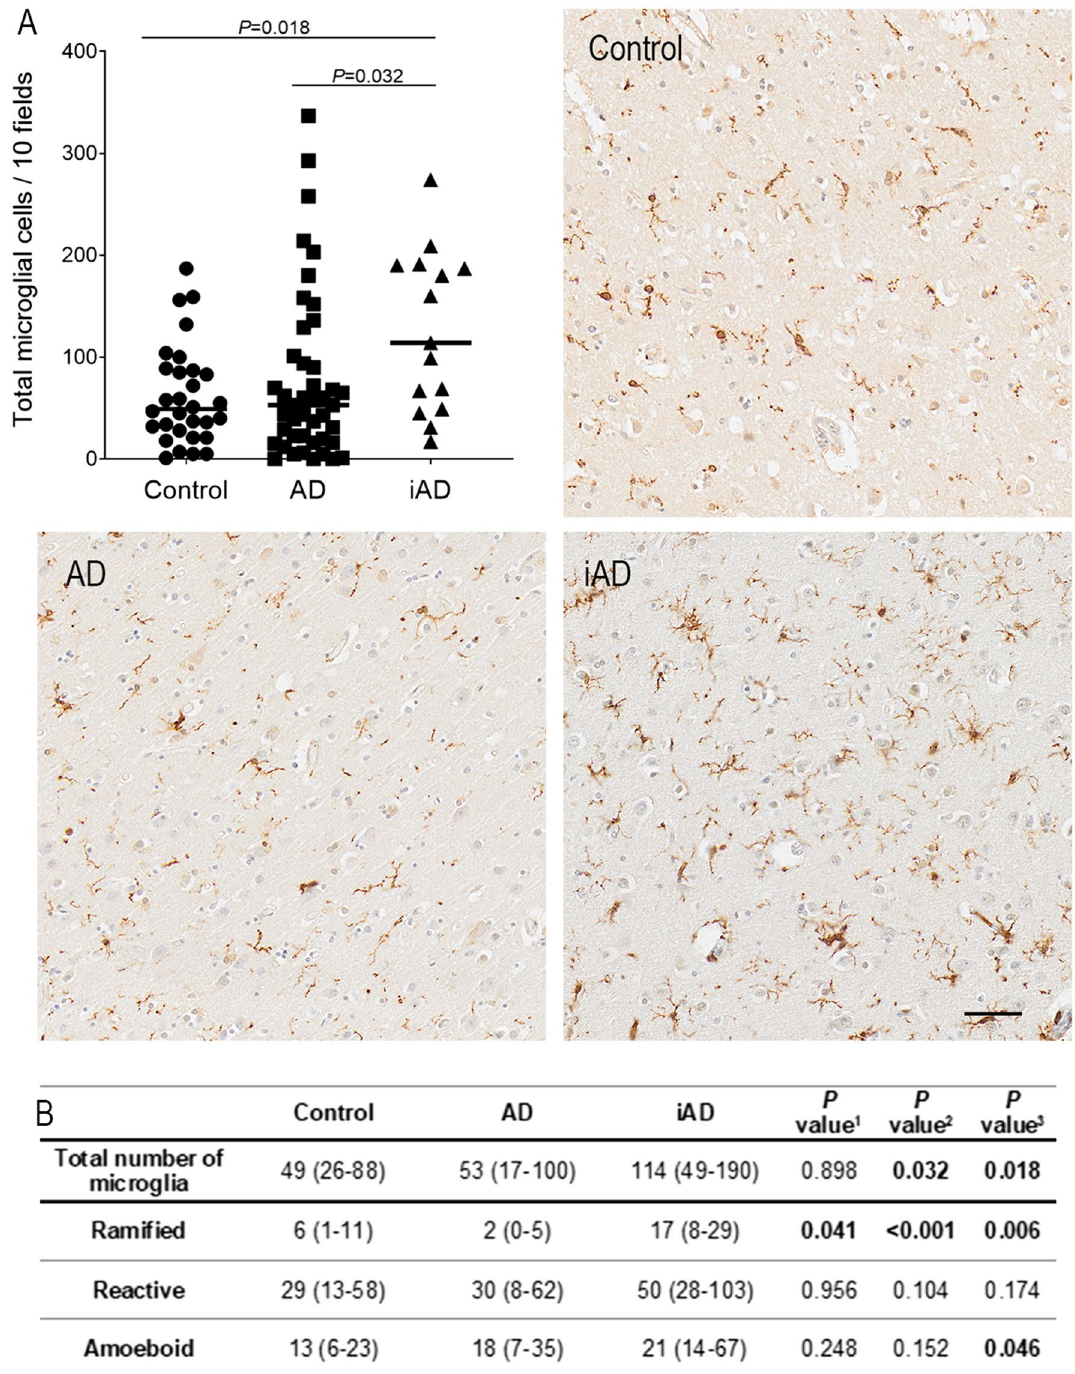
Figure 1. ( A ) Graph and illustration of the number of microglia within the three groups showing increased Iba1 + microglial cells in the iAD group compared to control and AD groups. Haematoxylin counterstaining. Brain area: inferior parietal lobule. Scale bar = 50 µm. ( B ) Quantification of number of microglial cells per 10 fields in 32 controls, 44 AD and 16 iAD cases. Total n = 192 cases. Values in the tables are presented as median with IQR. P value by Kruskal–Wallis test with Benjamini–Hochberg correction for multiple testing— P value 1 : control vs AD; P value 2 : AD vs iAD. P value 3 : Control vs iAD. Significant P value in